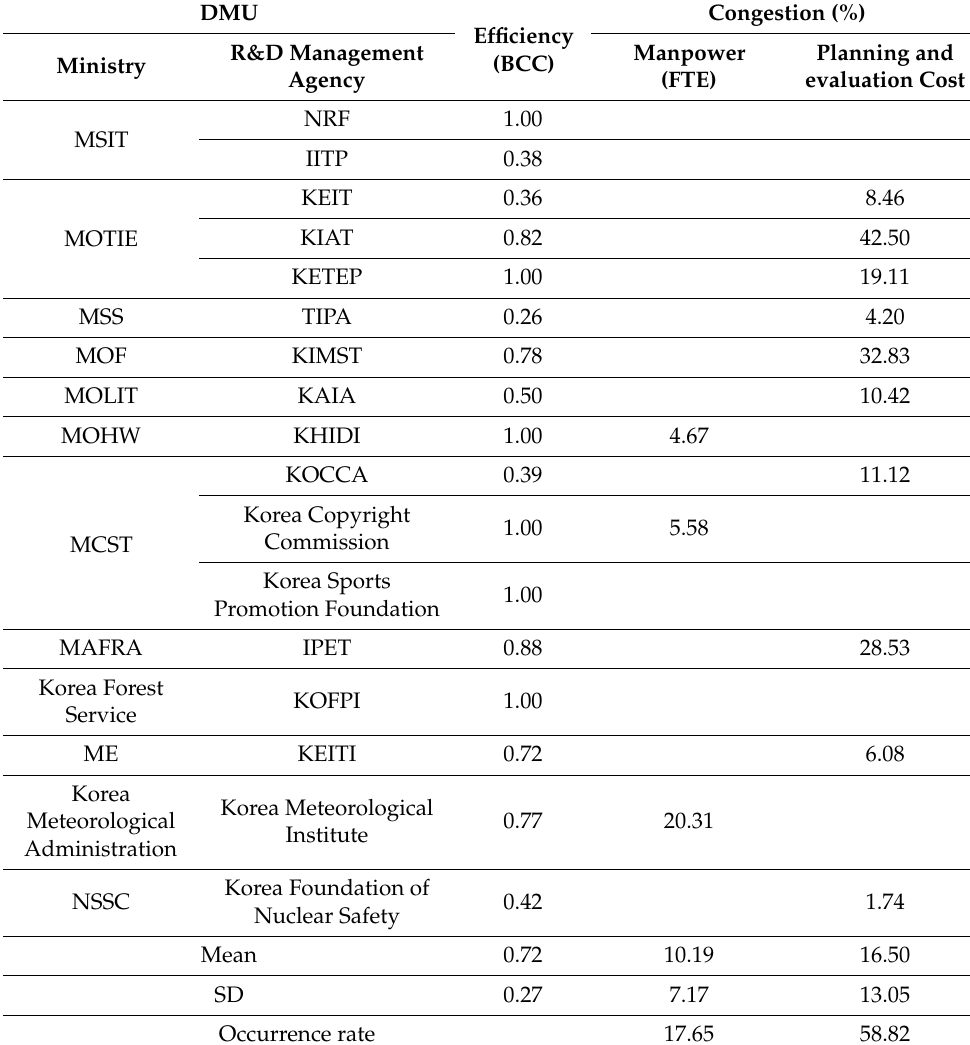
Table 10. Congestion analysis results of R&D